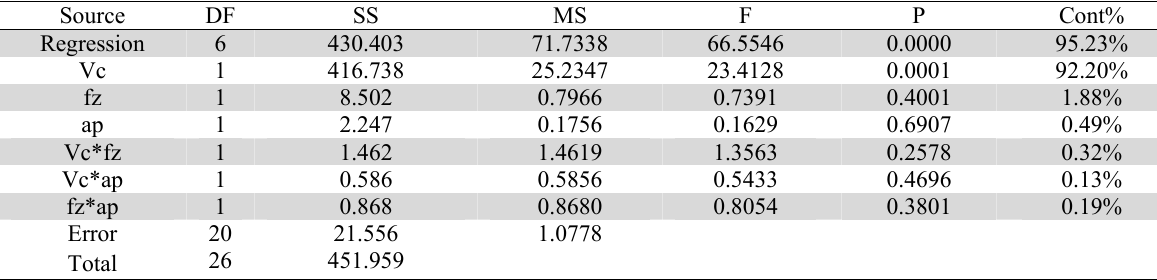
Analysis of variance for the surface roughness